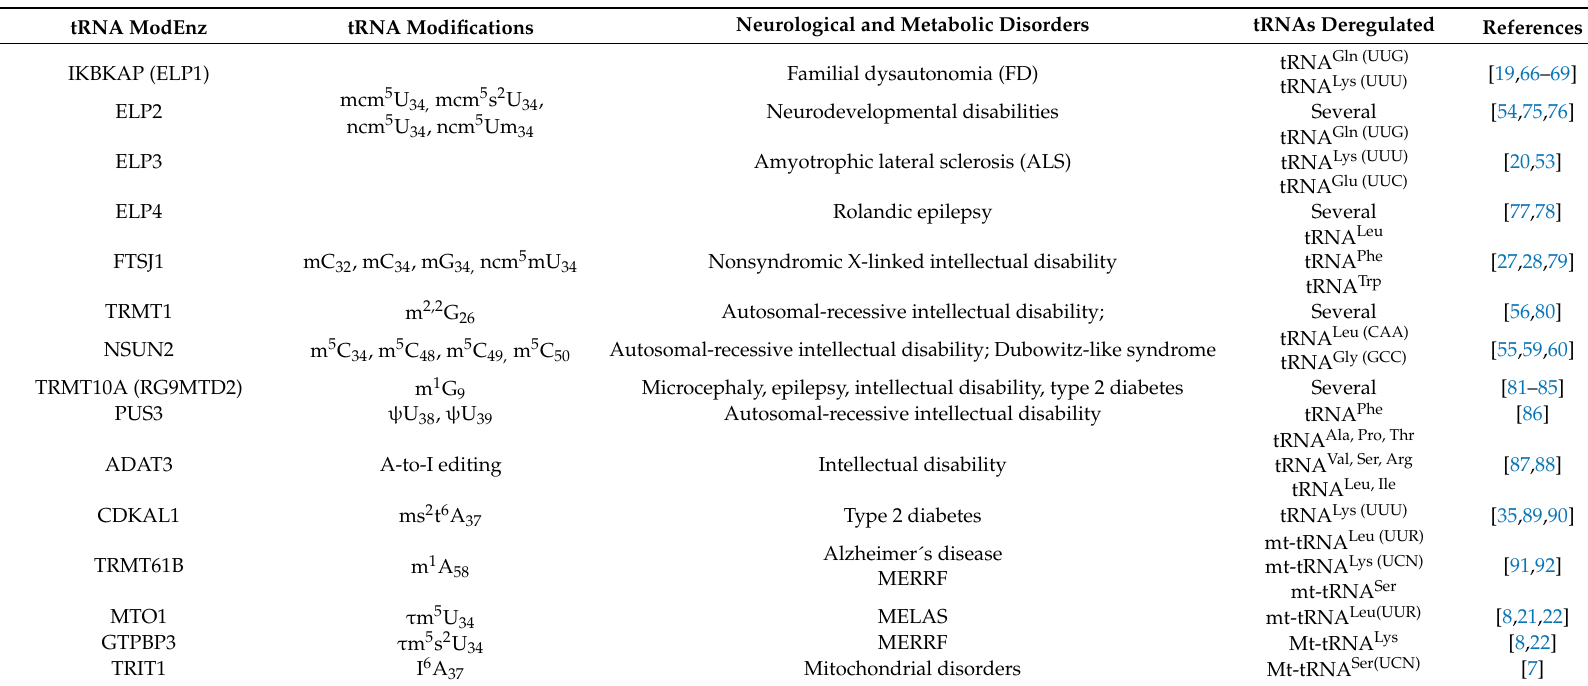
Table 1. List of tRNA ModEnz, tRNA modifications, and tRNA deregulations associated with neurological and metabolic